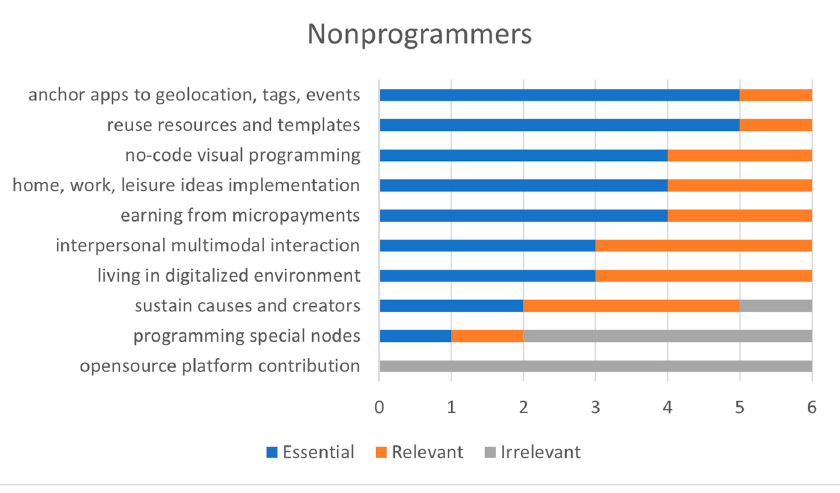
Figure 16. Most desired characteristics by non-programmers in order to get involved with the plat- form.